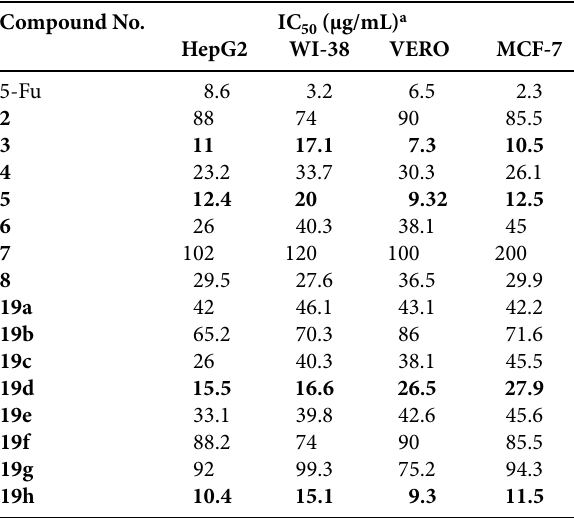
Table 1 : Cytotoxicity (IC 50 ) of examined sulfonamides on various cell lines a Compound